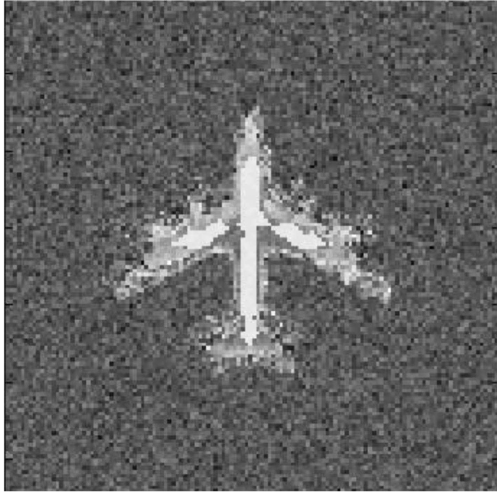
Figure 10. Visualization of response intensity of units in the first hidden layer of the input